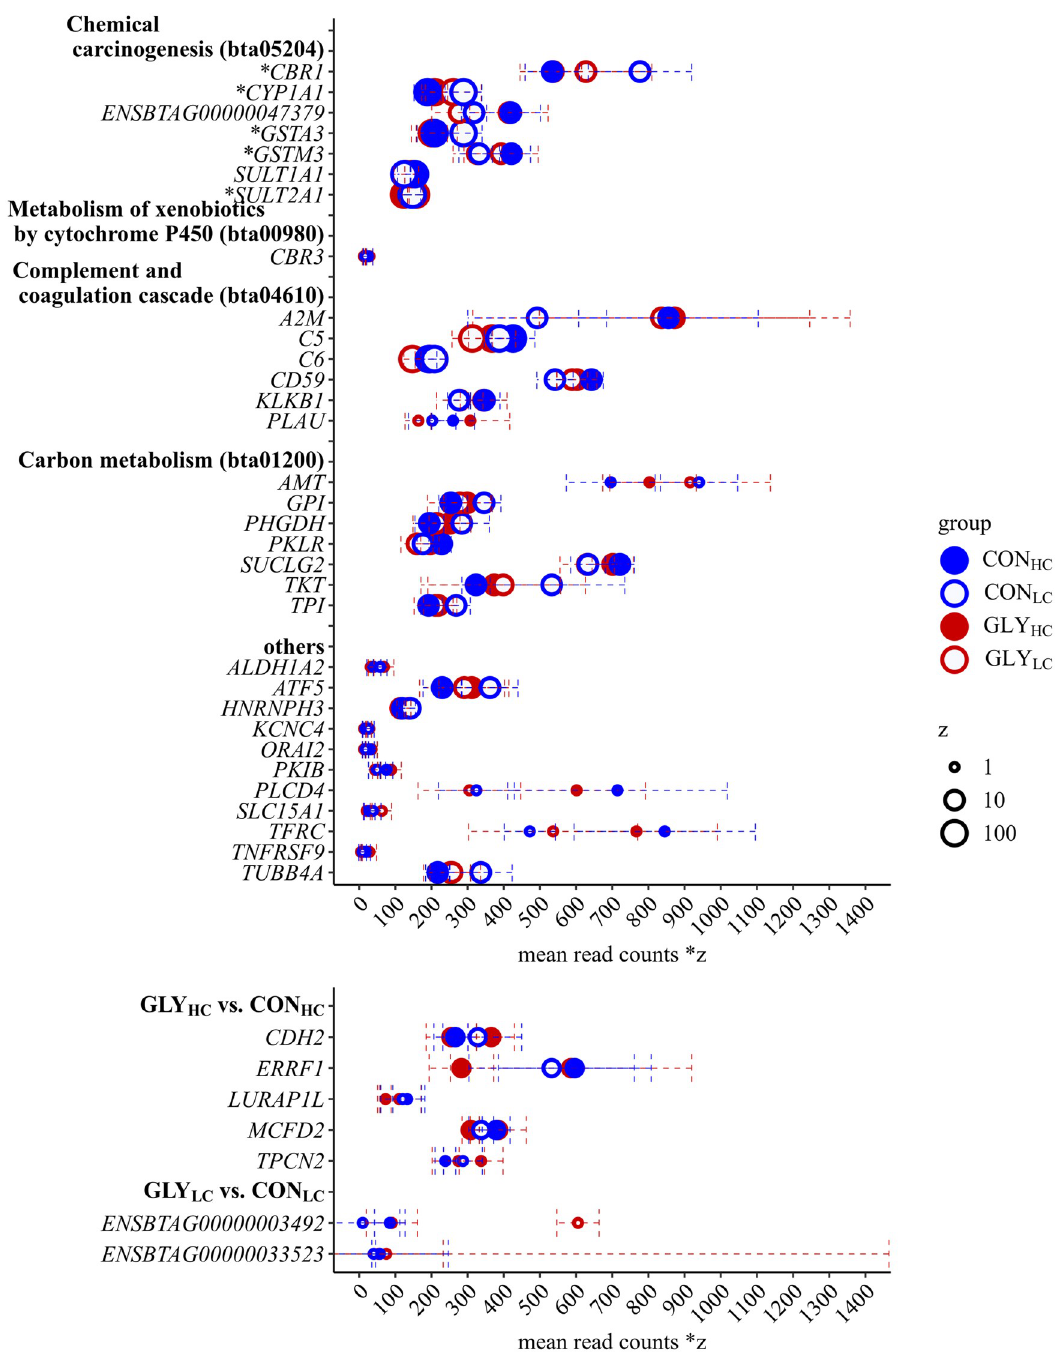
Fig 4. Differentially expressed genes with mean normalized read counts in respective feeding groups according to RNA- sequencing. Shown are mean normalized read counts (dots) and standard deviation (error bar) of KEGG pathway enriched DEGs and further non pathway enriched DEGs of particular interest in respective feeding groups (CON HC , CON LC , GLY HC and GLY LC ) upon different CFP (A) as well as all DEGs upon GLY-contaminations (B) in dairy cows’ rations. The size of dots represents the expression level, while Factor z was used for scaling. � DEGs were also enriched in “metabolism of xenobiotics by cytochrome P450”; CON = control; GLY = glyphosate; CFP = concentrate feed proportions; HC = high concentrate feed proportion in the diet; LC = low concentrate feed proportion in the